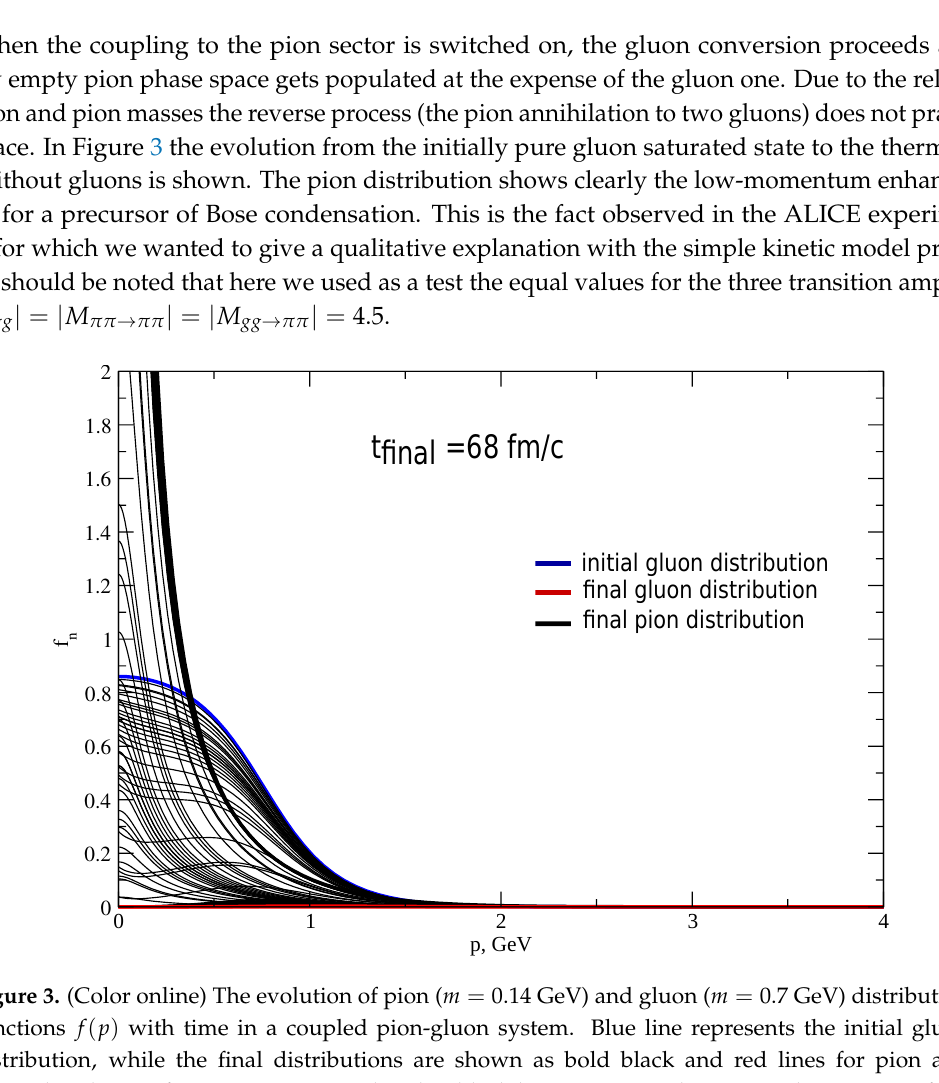
Figure 2. (Color online) Same as Figure 1 for different matrix elements | M | = 1, 4.5, 140.